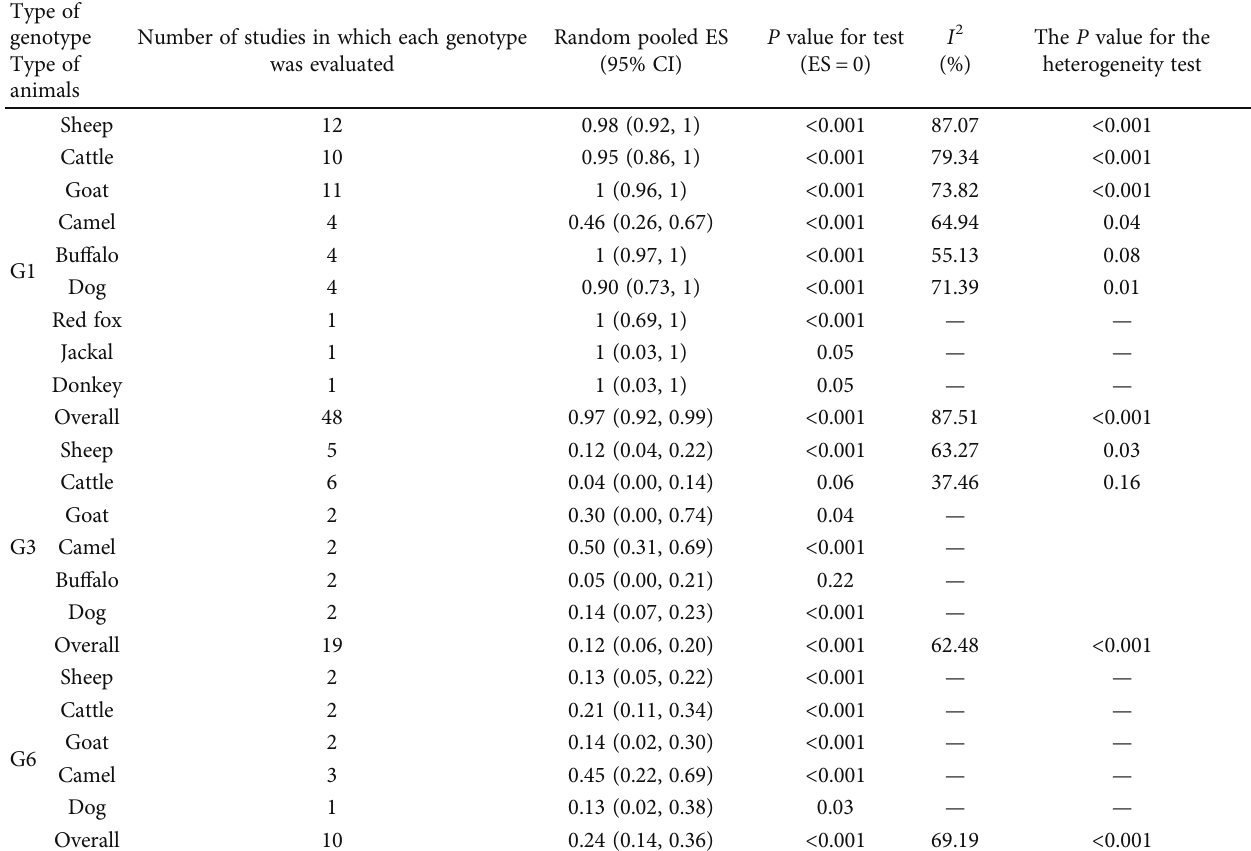
Table 4: Subgroup analysis of cystic echinococcosis genotypes prevalence by animal